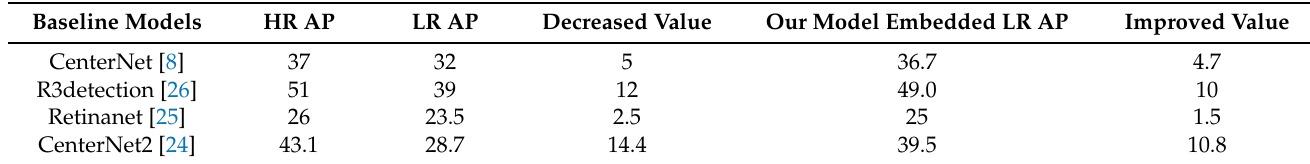
Table 2. Baseline Model Performance and Our Model Embedded Performance for Small Object Detection in Low-Resolution Remote Sensing Images.